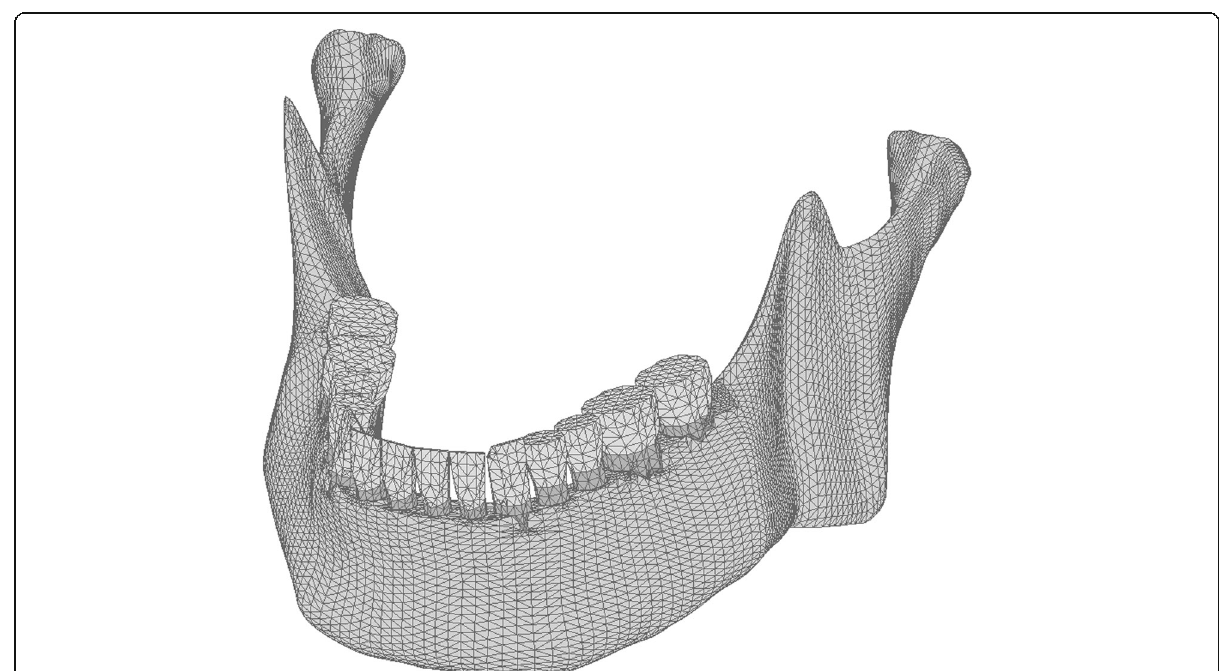
Fig. 4 Three-dimensional finite element model with natural teeth and no defect